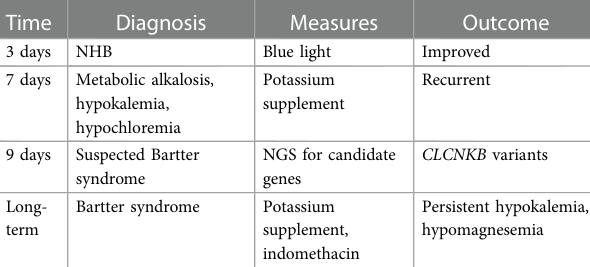
TABLE 2 Timeline of patient diagnoses and outcomes.